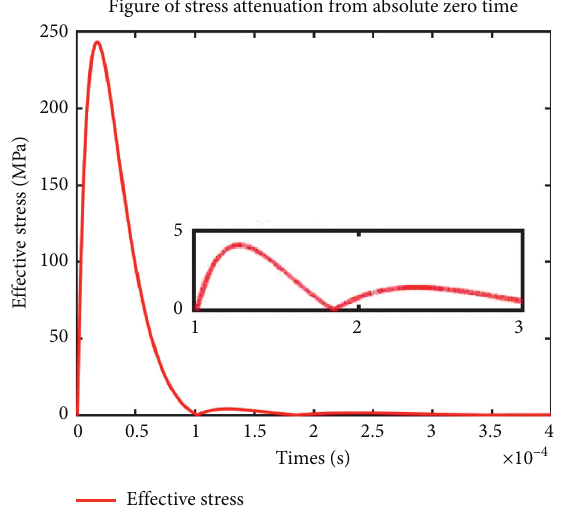
Figure 5: Effective stress attenuation from absolute zero time.